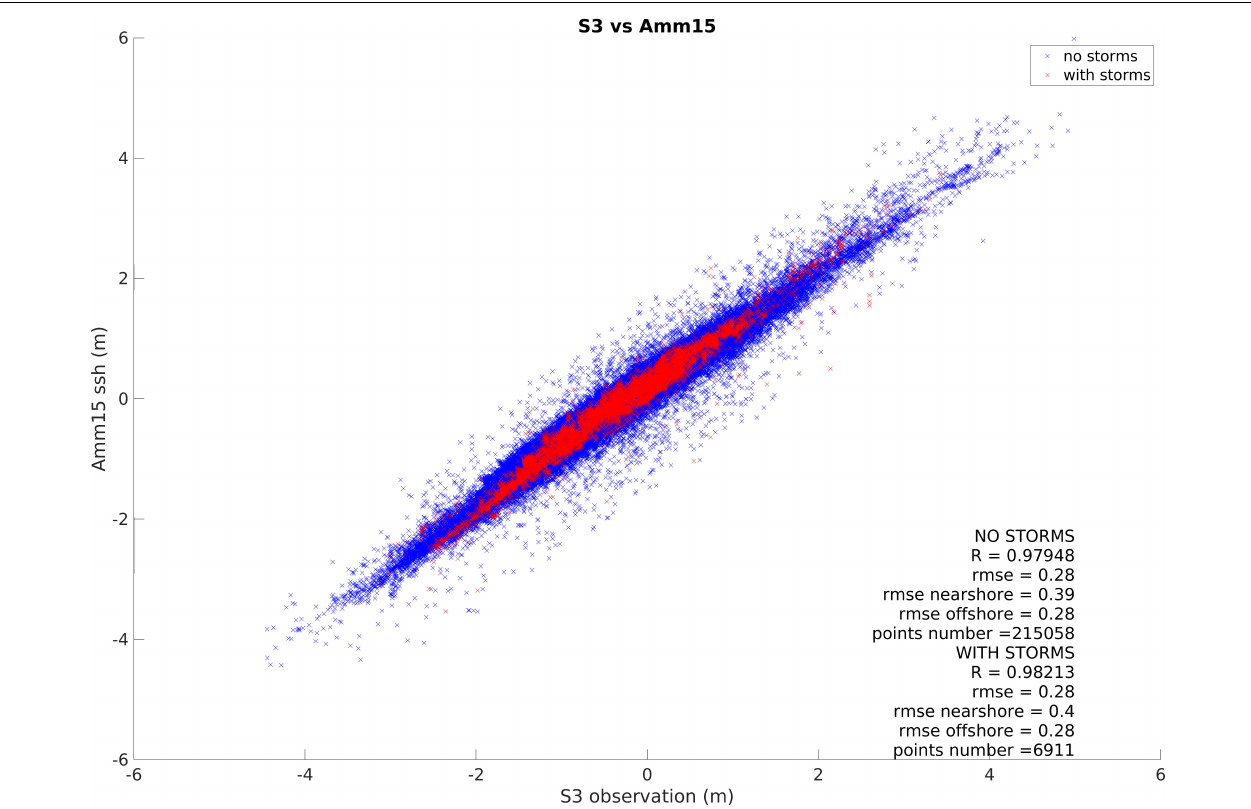
FIGURE 5 | Correlation between S3 and Amm15 during period with and without storms. The plot also shows the statistics calculated from values closer than 10 km from the coast (near shore) or further than 50 km from the coast